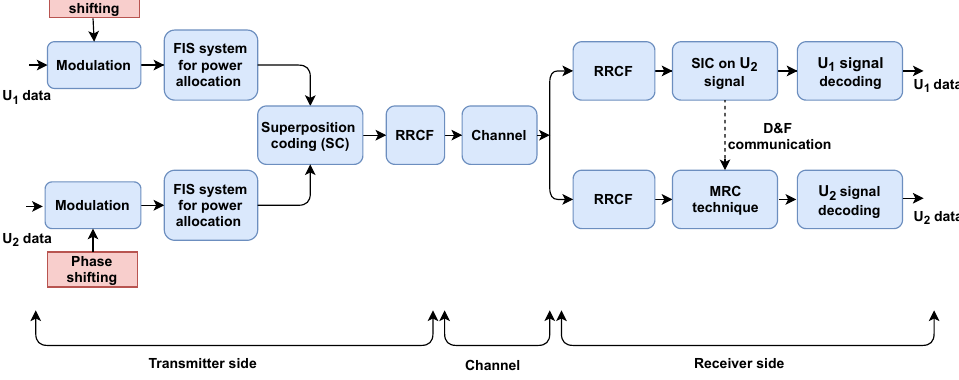
Figure 2. Block diagram of the proposed cooperative relaying FIS based PD-NOMA